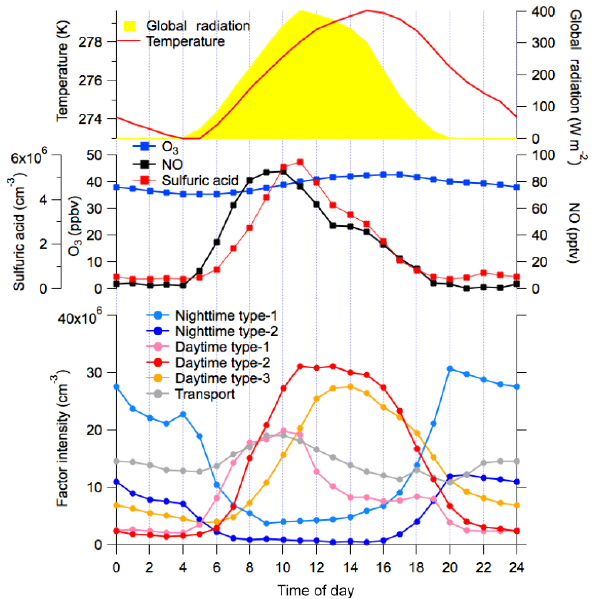
Figure 6. The diurnal cycle of PMF factors, selected meteorological parameters, and trace gas